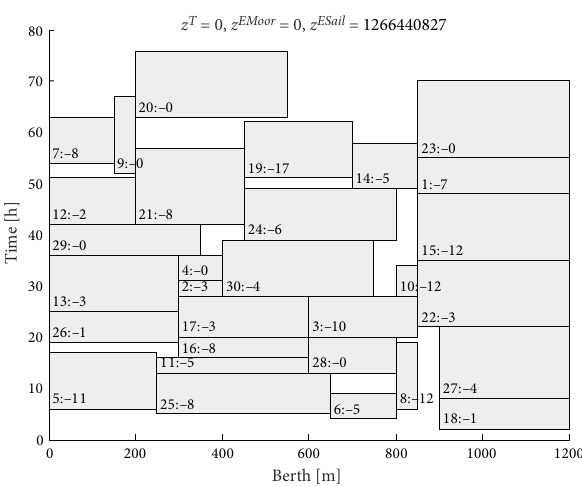
Figure 5. Minimizing mooring emission for zero delay and minimal sailing emission